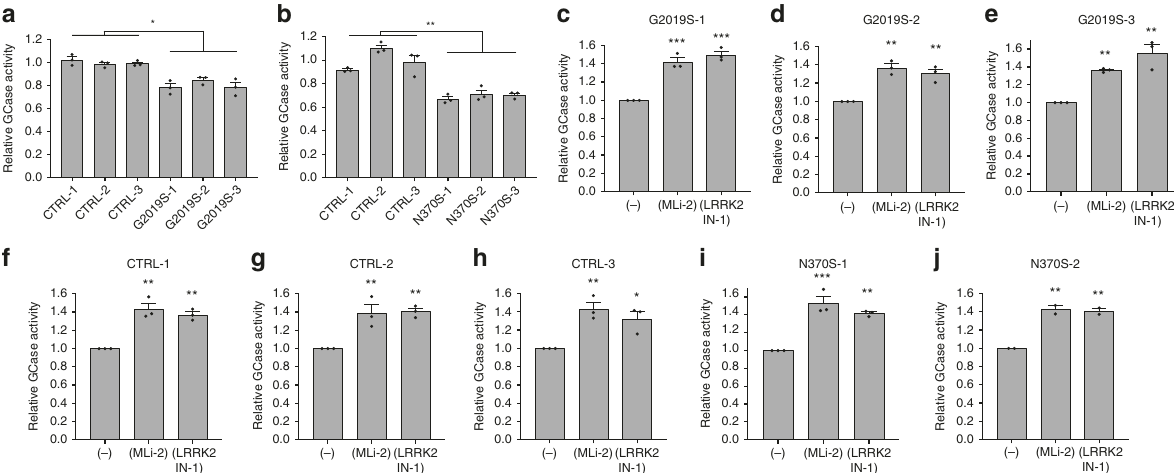
Fig. 4 GCase activity is negatively regulated by LRRK2 kinase activity in patient-derived fi broblasts. Comparison of live-cell lysosomal GCase activity in fi broblasts derived from healthy control individuals, as well as patients with LRRK2 G2019S a and GBA1 N370S b mutations. GCase activity in patient- derived fi broblasts with LRRK2 G2019S mutations treated with either the LRRK2 inhibitors MLi-2 (600 nM) or LRRK2-IN-1 (2 µ M) c – e . GCase activity measured in additional cultures derived from healthy controls f – h and from individuals with GBA1 N370S mutations i , j treated with either MLi-2 or LRRK2- IN-1. The data are presented as the mean ± SEM, n = 3 ( n = 2 for N370S-2); * p < 0.05, ** p < 0.01, *** p < 0.001 relative to healthy controls a , b or untreated c – j , with one-way ANOVA followed by Tukey ’ s multiple comparison post hoc test . Source data are provided as a Source Data fi